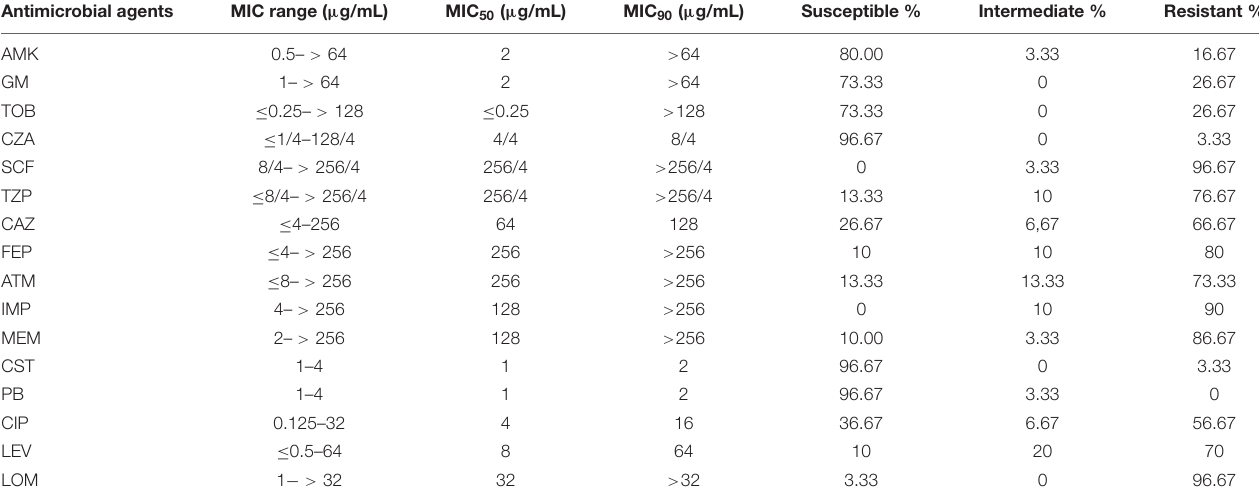
TABLE 1 | Antibiotic susceptibility profiles of P. aeruginosa . Antimicrobial agents